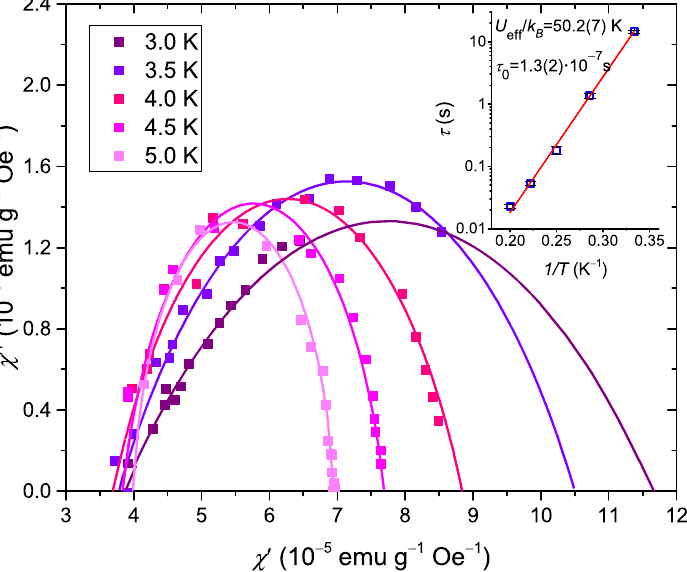
Figure 2. Argand plots for the sample SilS-Mn 12 measured in the frequency range of 0.1 Hz–1000 Hz with an oscillating magnetic field amplitude of H AC = 3 Oe for different temperatures (solid lines represent the best fit to Equation (1)) (inset: corresponding data of temperature dependence of the relaxation time on a log scale (solid line stands for the best fit to the Arrhenius function